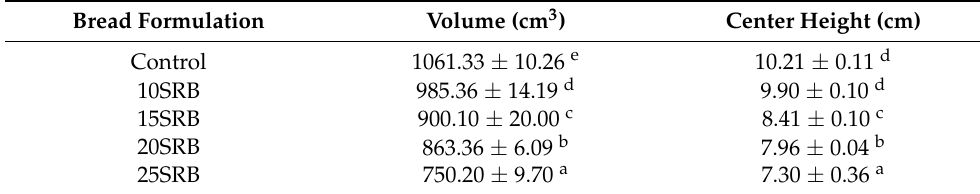
Table 5. Physical characteristics of control and experimental breads formulated with different levels of SRB substitution. Bread Formulation